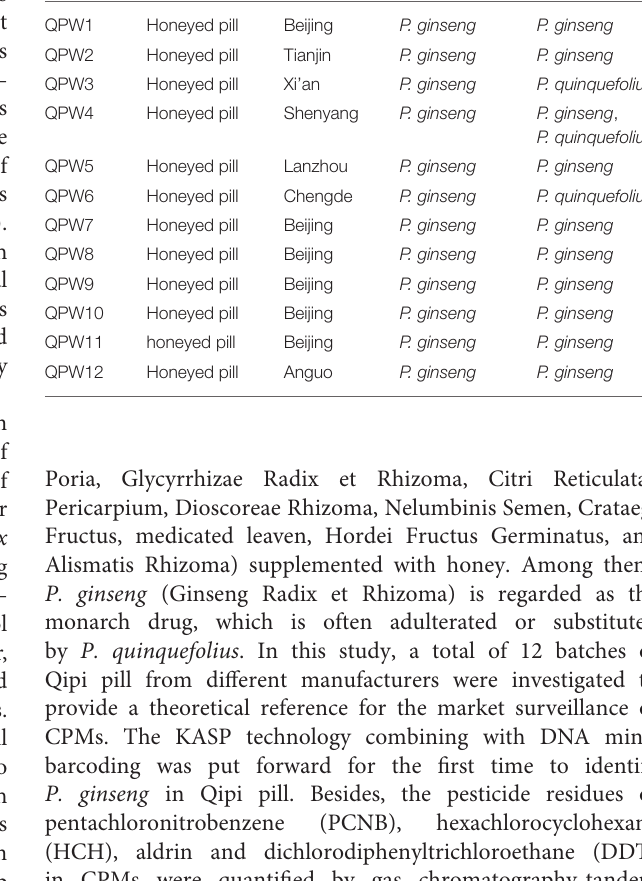
TABLE 1 | Sample information of Qipi pill in this study. Sample